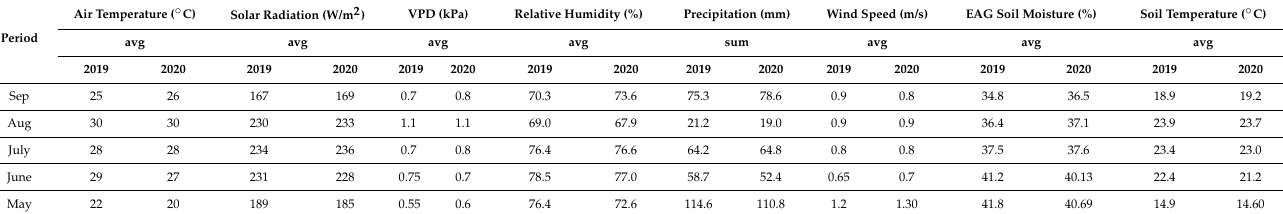
Table 1. Meteorological conditions